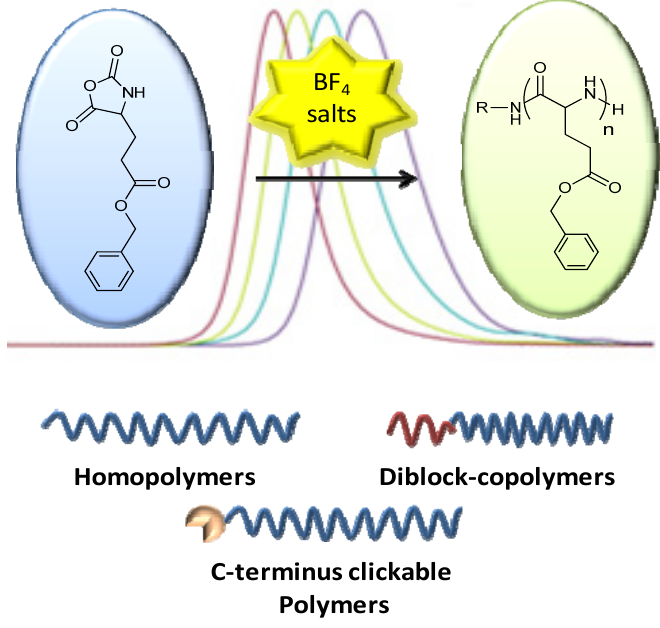
Figure 5. Schematic representation of the NCA polymerisation methodology developed by Conejos-Sanchez et al . (Adapted from Conejos-Sanchez et al . [51]). Reproduced by permission of The Royal Society of